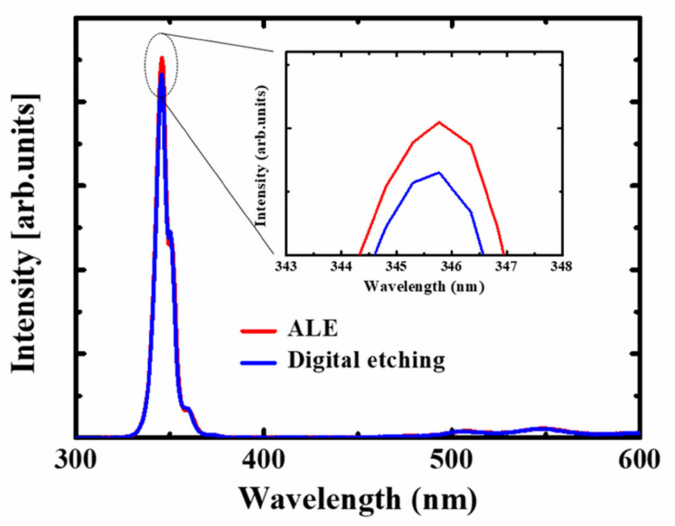
Figure 9. Photoluminescence (PL) characteristics for the etched